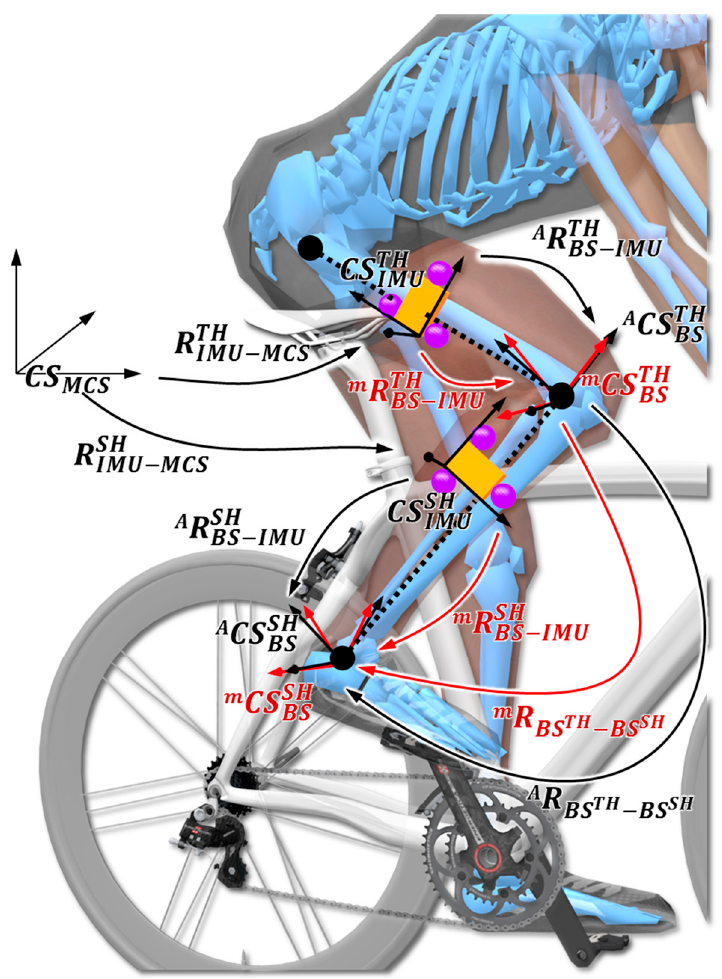
Figure 2. Coordinate systems definition and the rigid transformations between them. Orange box represents the IMU sensors, whereas the purple spheres correspond to markers fixed on the IMU ( 𝐶𝑆 (cid:3003)(cid:3020)(cid:3020)(cid:3009)(cid:3002) and 𝐶𝑆 (cid:3003)(cid:3020)(cid:3021)(cid:3009)(cid:3002) ) referring to the anatomical body segment coordinate systems (black vectors) and technical body segment frame (red vectors) for the thigh and the shank ( 𝐶𝑆 (cid:3003)(cid:3020)(cid:3020)(cid:3009)(cid:3040) and 𝐶𝑆 (cid:3003)(cid:3020)(cid:3021)(cid:3009)(cid:3040) ). 𝐶𝑆 (cid:3010)(cid:3014)(cid:3022)(cid:3021)(cid:3009) and 𝐶𝑆 (cid:3010)(cid:3014)(cid:3022)(cid:3020)(cid:3009) represent the IMU coordinate systems for the thigh and the shank. 𝐶𝑆 (cid:3011) defines the knee joint coordinates following the recommendation of the International Society of Biomechanics [45].